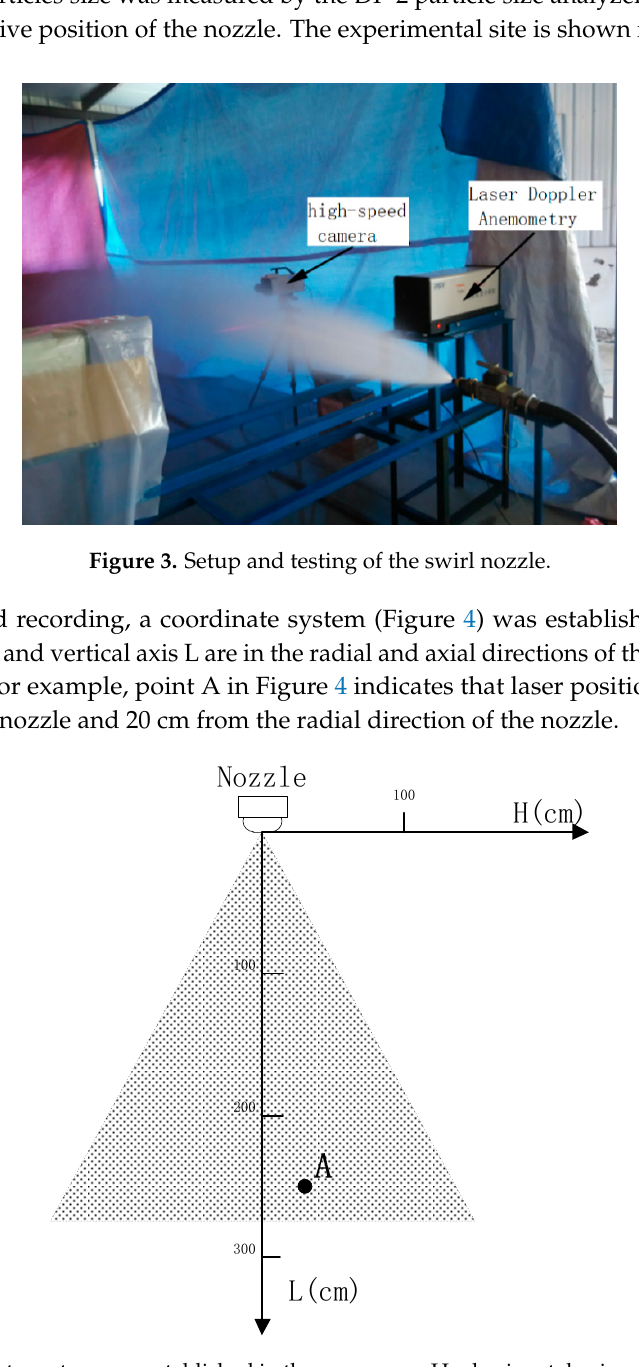
Figure 4. Coordinate system was established in the spray area. H = horizontal axis and L = vertical axis.